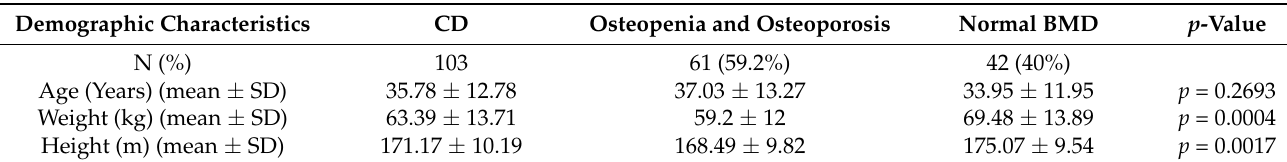
Table 2. The demographic and anthropometric parameters of the studied CD patients with respect to osteoporosis and